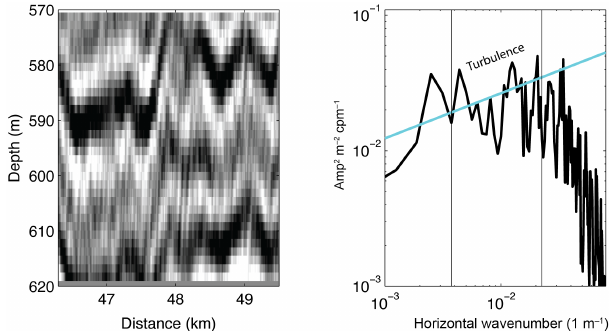
Figure 7. Seismic data and data transform of a representative window from which relative turbulent energies are calculated and